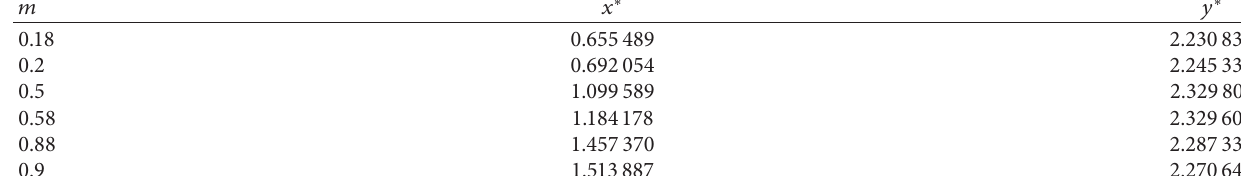
Table 2: The equilibrium point values of Case (ii).